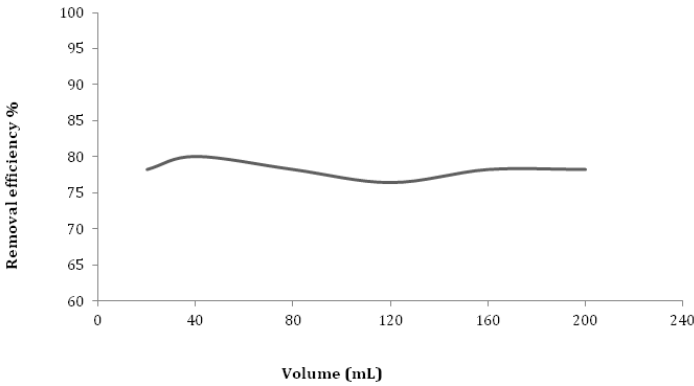
Figure 6. Mo removal efficiency by the natural faujasite–phillipsite tuff at different water volumes.